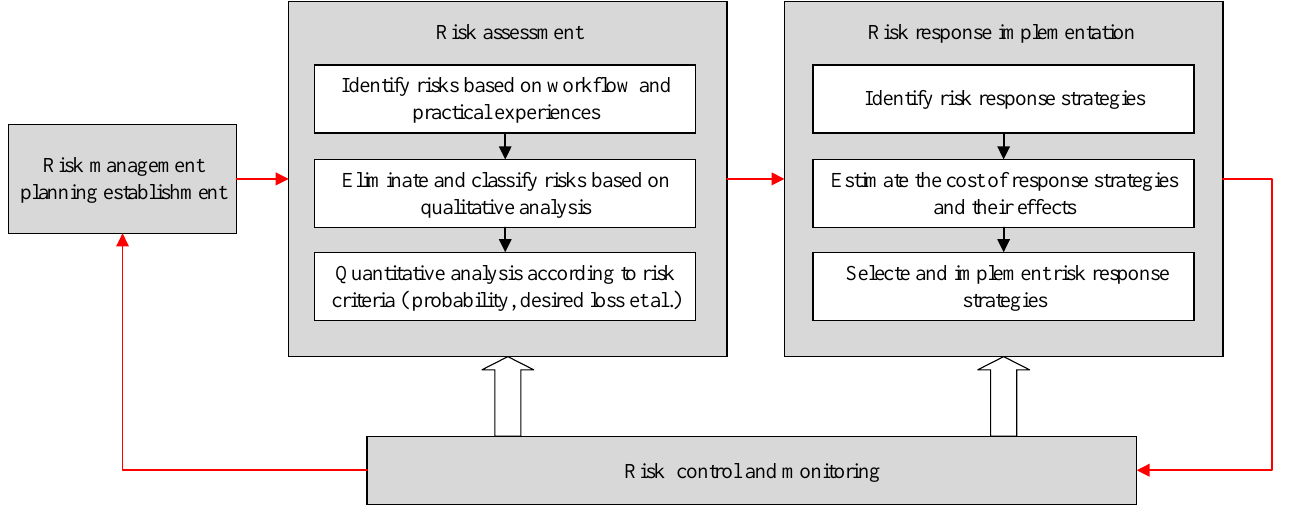
Figure 1. Overall risk management framework.